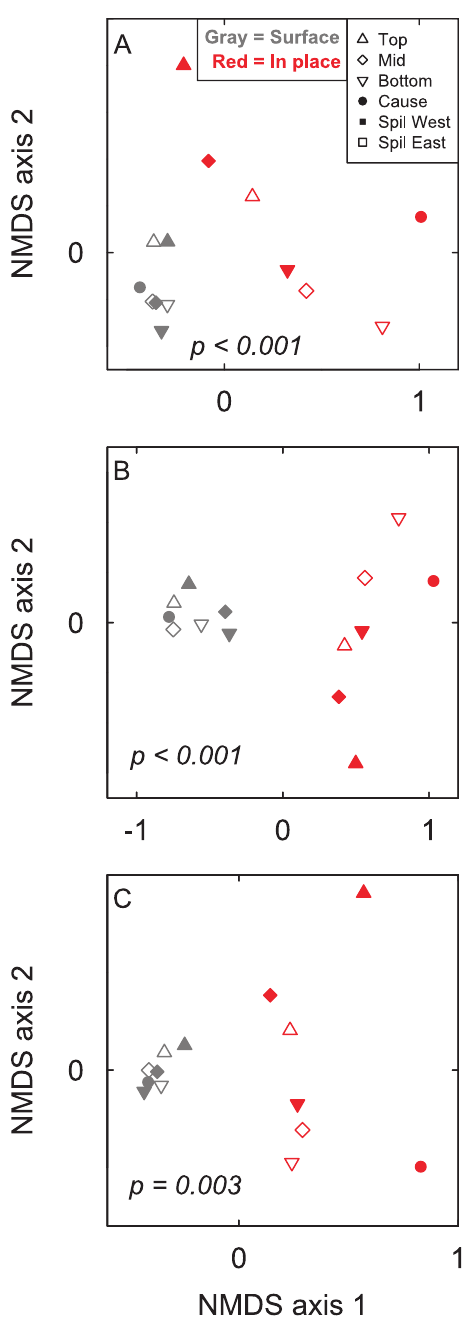
Fig 3. NMDS ordination of all samples. Non-metric multidimensional scaling (NMDS) ordination of all samples with all collector’s surface samples combined for (A) all taxa with abundance counts, (B) all taxa using presence/ absence, and (C) mollusks and brachiopods with abundance counts. Spillway East outcrop samples are represented by open points, Spillway West outcrop samples are represented by closed triangles and diamonds, and Causeway Road outcrop samples are represented closed circles. P-values result from the PERMANOVA testing for differences between the two sampling methods.